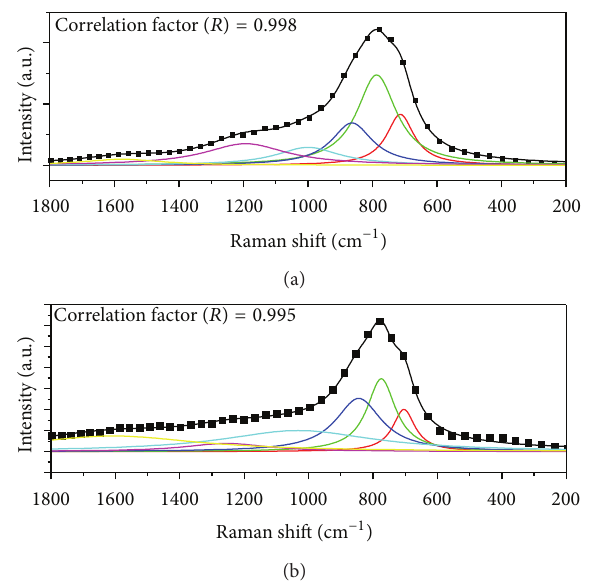
Figure 11: Raman spectrum with deconvolutions of samples (a) and (b).